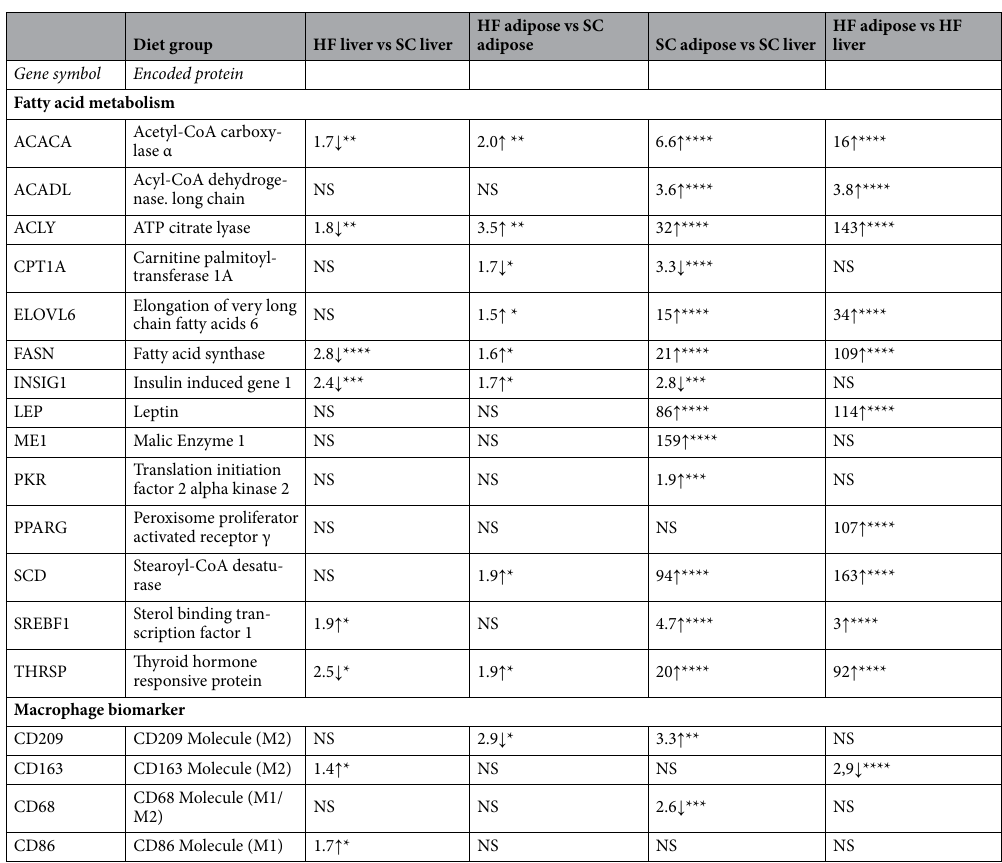
Table 2. Liver and adipose RNA profiling. The columns show significant fold change in regulation of gene expression between the indicated groups. Arrows indicate up-( ↑ ) or down ( ↓ ) regulation in the first compared with the second mentioned group. Each data point represents two tissue samples from each pig and two replicates per sample. Groups were compared pair-wise using Student’s t-test or the Mann Whitney Wilcoxon Test, and significant differences are indicated by * p < 0.05, ** p < 0.01, *** p < 0.001, and **** p < 0.0001. NS; not significant different.